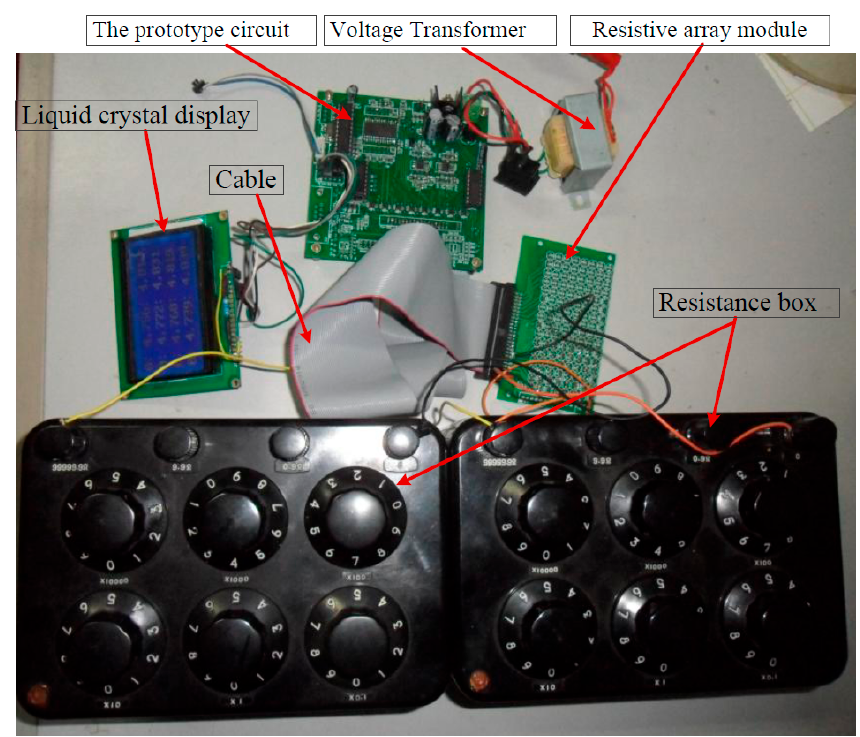
Figure 9. The experimental setup of the prototype circuit.